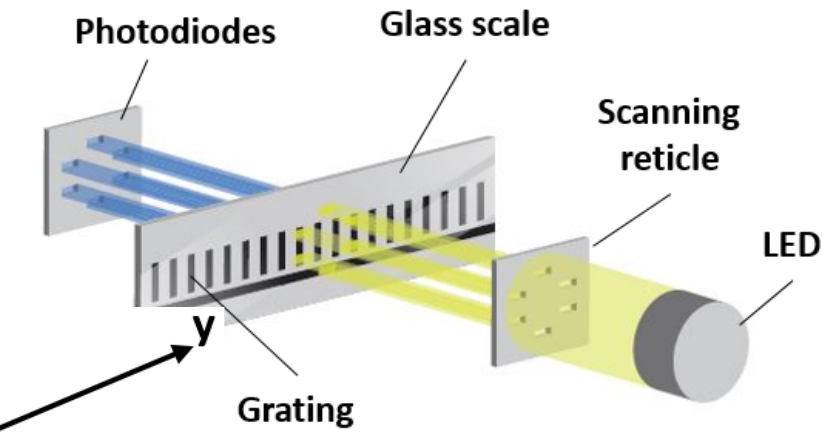
Figure 2. Optical principle of Moiré-based optical linear encoders.